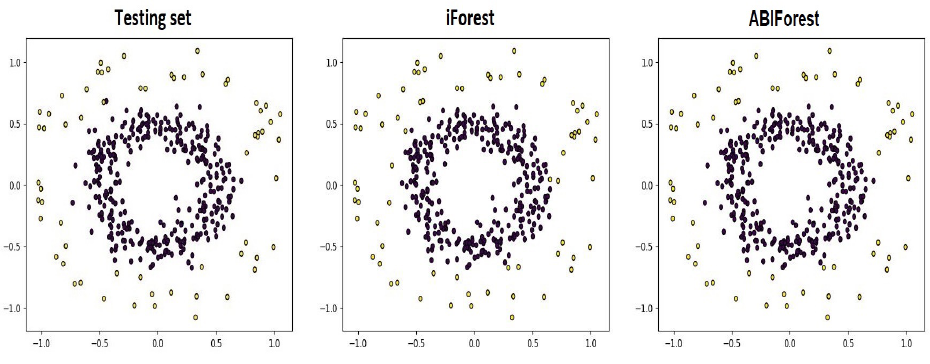
Figure 6. Comparison of the test set generated for the Circle dataset (the left panel), predictions obtained by iForest (the central panel), and predictions obtained by ABIForest (the right